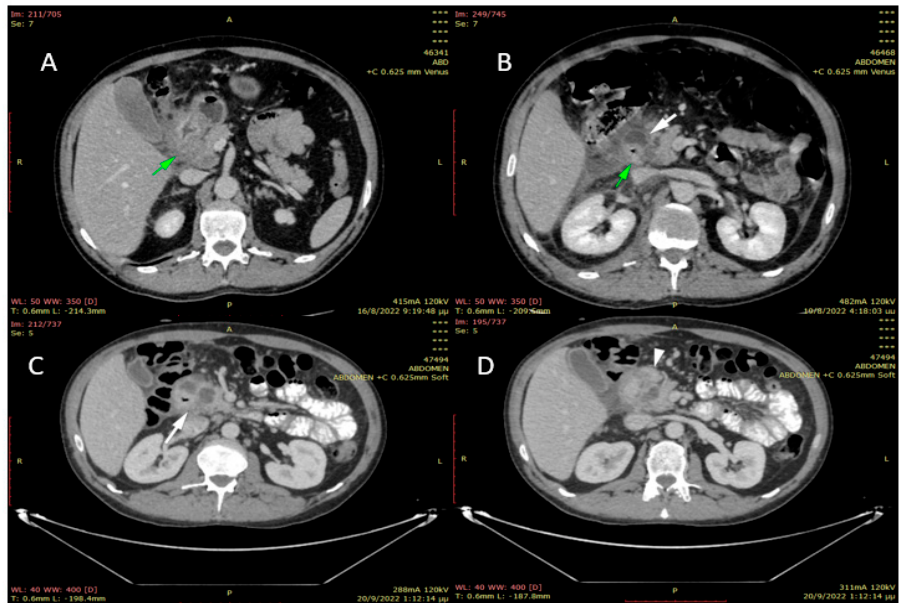
Figure 1. CT findings. ( A ): Admission CT: extensive edema of the duodenal wall and head of the pancreas (arrow). Normal biliary tree. ( B ): 3 days later: duodenal wall edema (green arrow) with cystic lesion formation (white arrow). The adjacent fat tissue is hyperdense due to inflammation. There is also free fluid collection in the anterior pararenal region. ( C ): 1 month after onset of symptoms: subtle increase of the cystic lesions on the duodenal wall. Extensive gastric and duodenal wall edema. ( D ): Same CT: Tissue to gastric antrum that enhances exactly the same as the rest of the pancreas (arrowhead) - ectopic pancreatic tissue Fat stranding and small fluid collection.